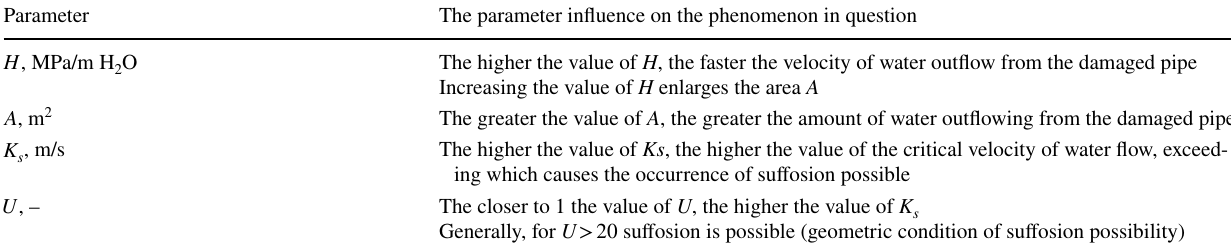
Table 4 Summary of the influence of the elements of the set Z ” (11) on the phenomenon in question Parameter The parameter influence on the phenomenon in question H , MPa/m H 2